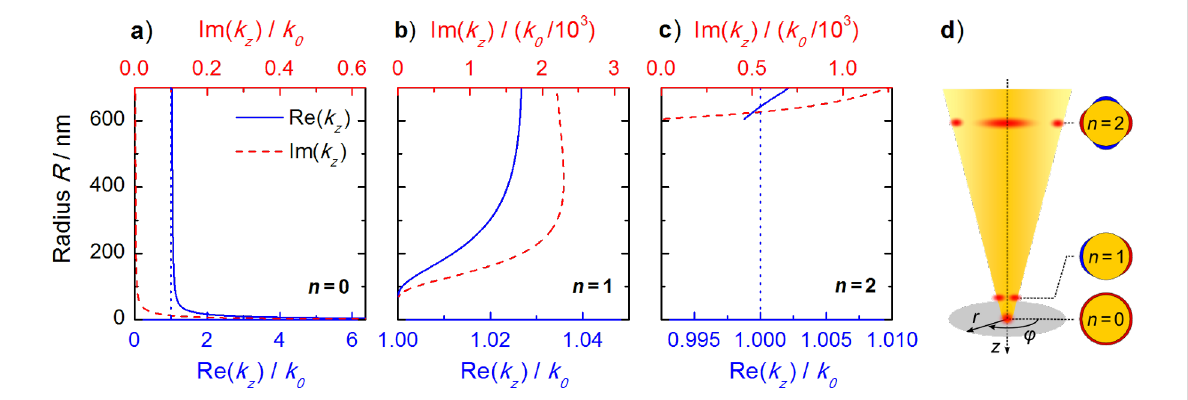
Figure 2: Propagation constants k z of the three lowest eigenmodes of an infinitely long gold wire as a function of wire radius R . Displayed are the real (solid blue lines) and imaginary (dotted red lines) parts of k z pointing along the taper axis for angular momenta n = 0,1,2 (panels a)–c)). The SPP frequency corresponds to a vacuum wavelength of 800 nm, as used in the experiment. For n = 0, both Re( k z ) and Im( k z ) diverge for small radii. For n = 1, k z approaches the light line, k 0 = ω / c 0 , for small radii. A cutoff behavior at approximately 600 nm is observed for n = 2. Panel d) summarizes these findings and schematically illustrates the mode